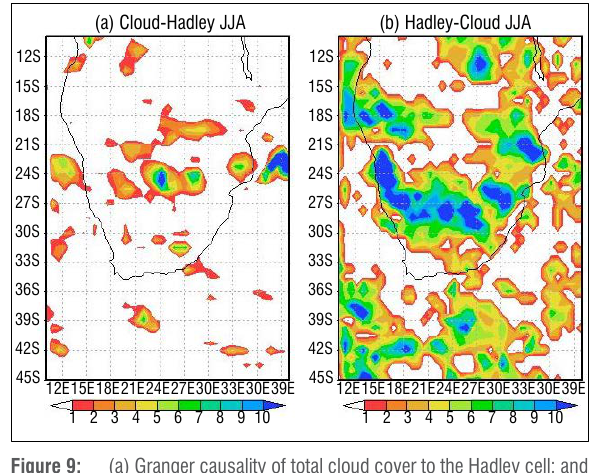
Figure 9: (a) Granger causality of total cloud cover to the Hadley cell; and (b) Hadley cell to total cloud cover in June–August (JJA).